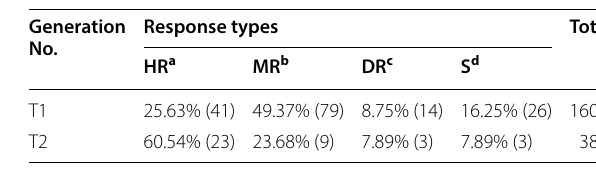
Table 3 Response types of T1 and T2 positive plants at V1– V4